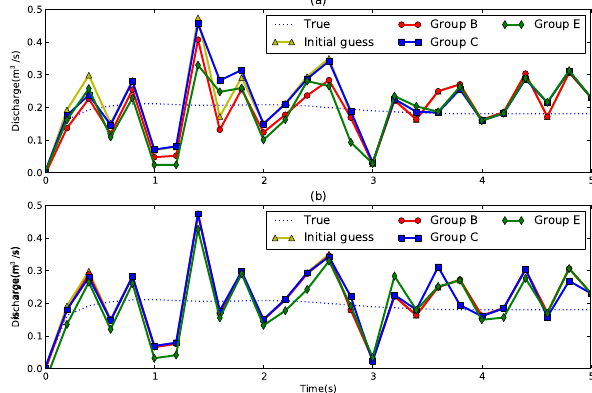
Figure 4. Identified discharge hydrograph from (a) experiment se- ries B and (b) experiment series